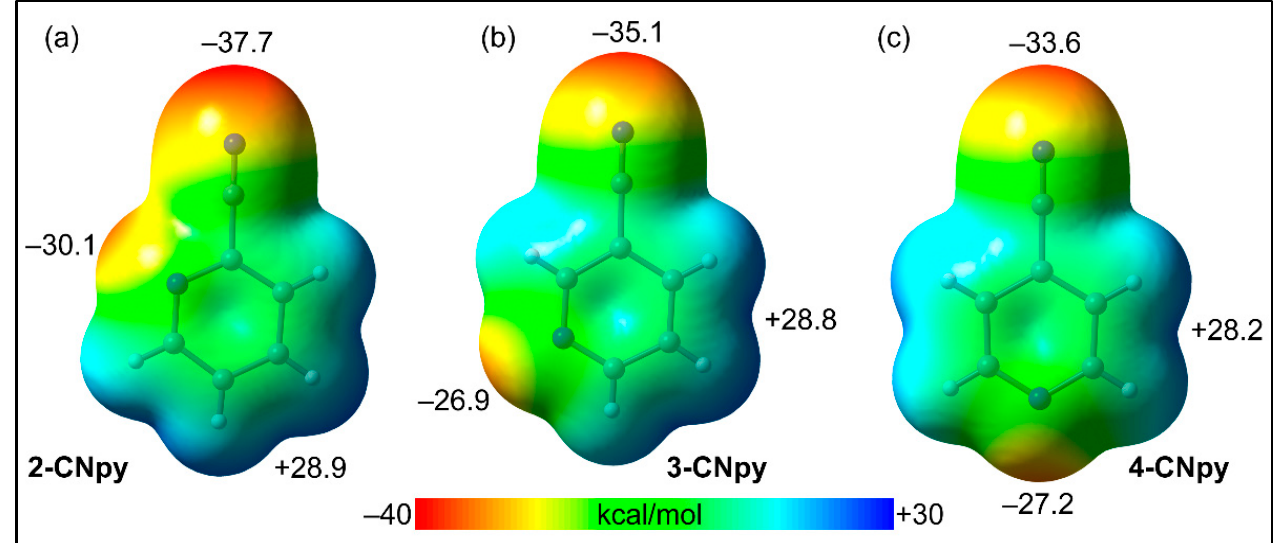
Figure 6. MEP surfaces of compounds 2-CNPy ( a ), 3-CNPy ( b ) and 4-CNPy ( c ) at the PB86-D3/def2-TZVP level of theory. The energies at selected points are given in kcal/mol. Isosurface 0.001 a.u.